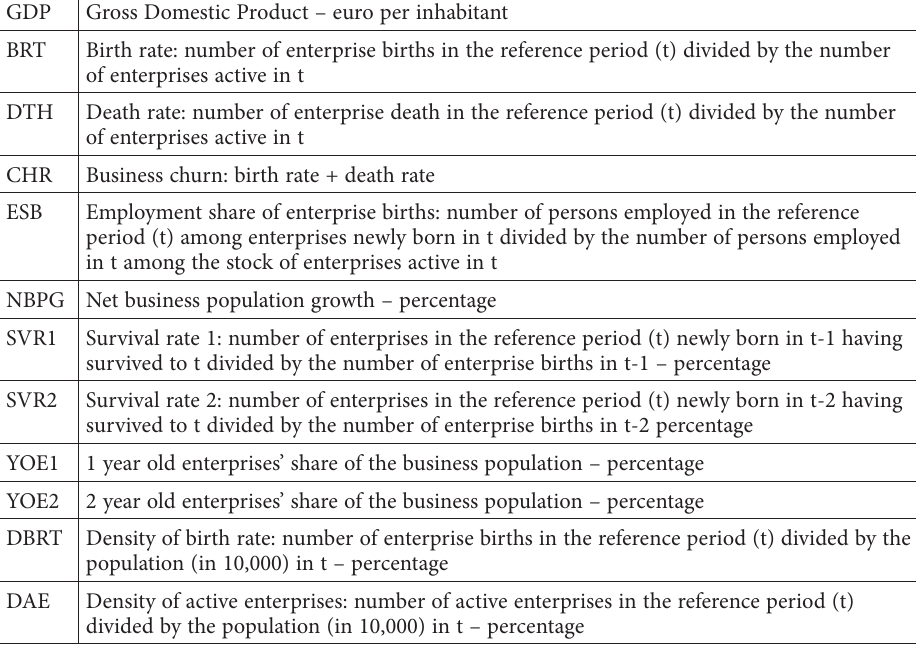
1166 Table 1. List of variables used in the analysis (source: authors’ selection based on Eurostat (2019a, 2019b, 2019c) GDP Gross Domestic Product – euro per inhabitant